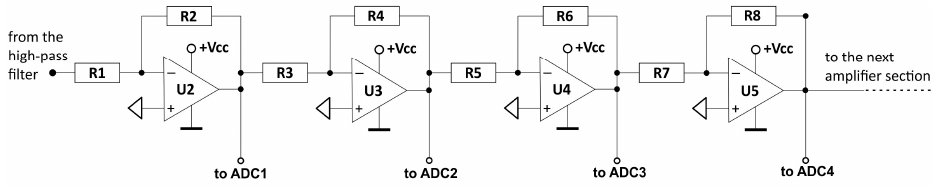
Figure 14. Diagram of the four-section ripple-curry amplifier.